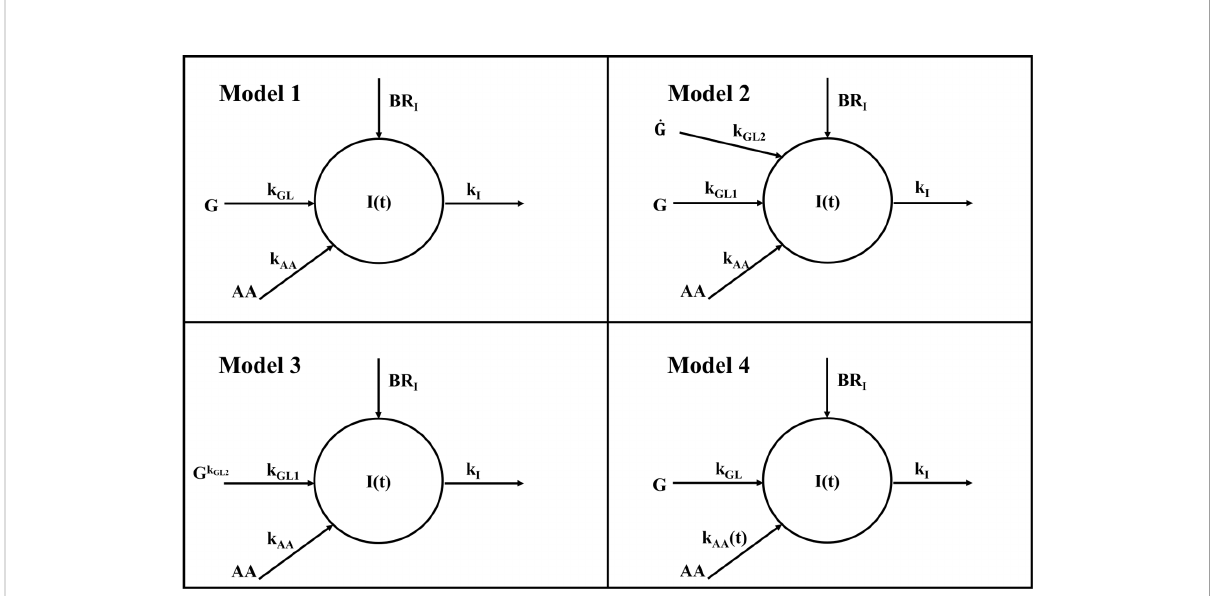
FIGURE 1 Compartmental representation of the four single-compartment model. All models are composed by a single compartment representing plasma insulin I(t). Plasma glucose G acts as input for all models through the k GL parameter for Model 1 and 4 and k GL1 for Model 2 and 3; similarly, amino acids act as input for all models through k AA parameter for Model 1, 2 and 3 and through the time-varying parameter k AA (t) for Model 4. In all models, k I represents the insulin elimination rate from plasma and BR I is the basal insulin appearance rate due to factors other than glucose and amino acids. In Model 2, a further dependence on glucose rise is included through the k GL2 parameter; in Model 2 this rise is accounted for by glucose derivative G ˙ hereas in Model 3 by glucose exponentiation G(t)k GL2